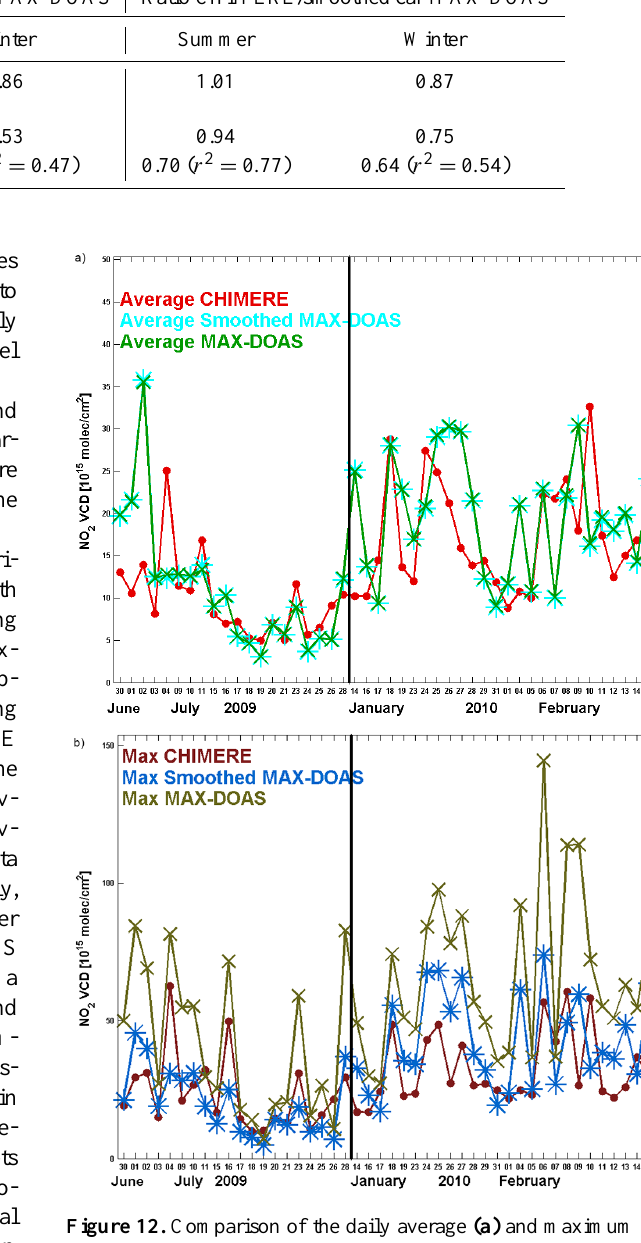
Figure 12. Comparison of the daily average (a) and maximum (b) tropospheric NO 2 VCDs for original and smoothed car-MAX- DOAS observations (all data) and coincident CHIMERE